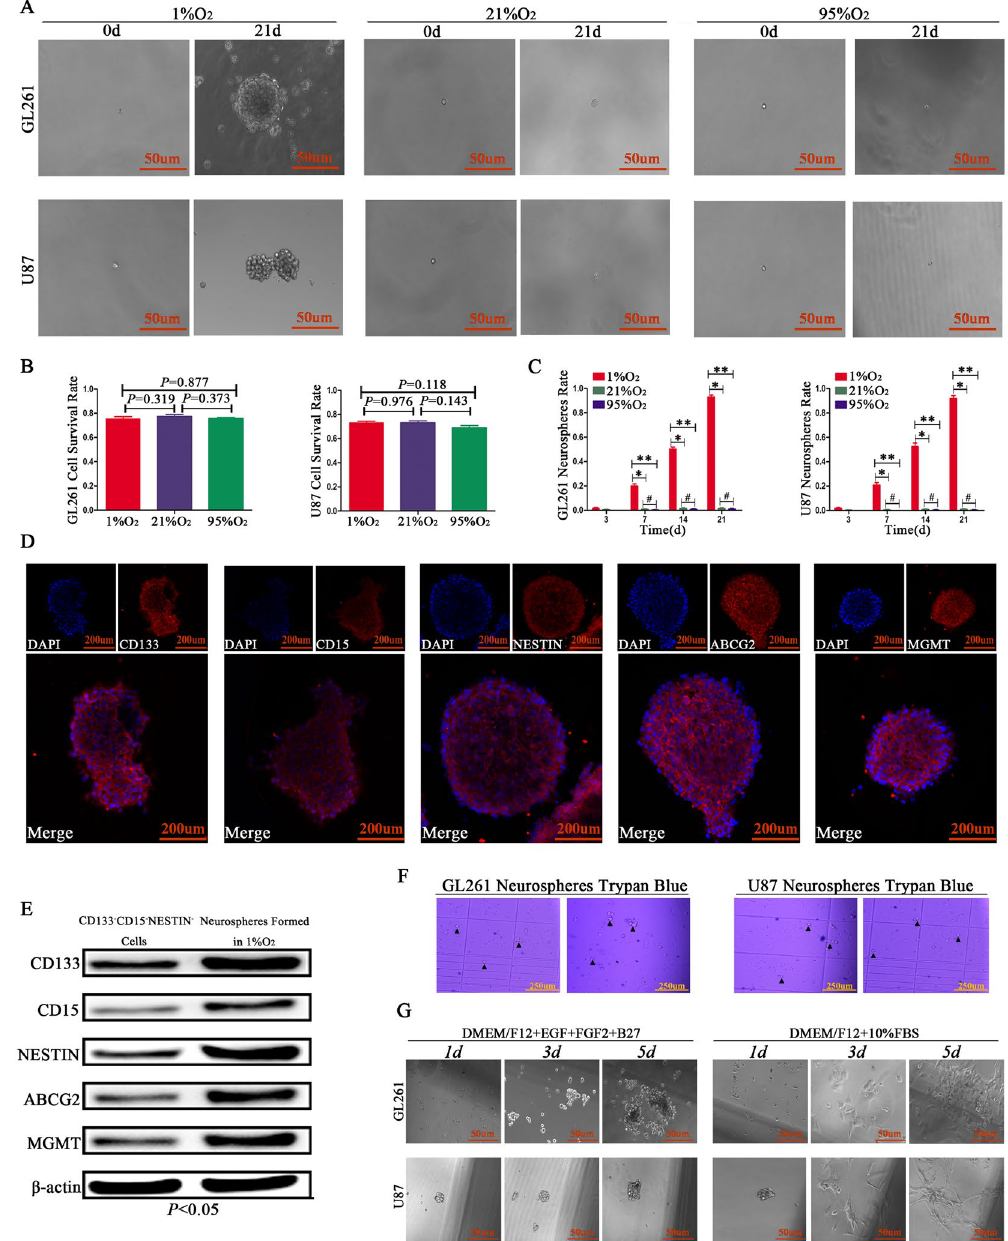
Figure 3. Neurospheres formed in 1%O 2 presented with features of GSCs. ( A–C ) Single GL261 and U87 CD133 − CD15 − NESTIN − cell was seeded in the wells of 96-well plates and cultured in 1%O 2 , 21%O 2 and 95%O 2 . Approximately 75% of cells survived after exposure to different oxygen levels for 3 days without a significant difference (d3 viable cells/d0 seeding cells). The neurospheres began to form after 1%O 2 exposure for 3 d, and approximately 20% of cells (d7 spheres/d3 surviving cells) from GL261 and U87 formed neurospheres on day 7. The neurosphere formation rates then significantly increased, and 50.2% ± 4.167 from GL261 and 53.0% ± 3.391 from U87 (d14 spheres/d3 surviving cells) formed neurospheres after hypoxia exposure for 14 d. More surprisingly, the sphere rates eventually reached 93.1% ± 5.541 from GL261 and 95.6% ± 2.665 from U87 (d21 spheres/d3 surviving cells) under hypoxic conditions for 21 days. However, in normoxia or hyperoxia, no distinct neurospheres formed, and most cells remained a single cell and eventually died ( * P < 0.05; ** P < 0.05; # P > 0.05, One-way ANOVA). ( D,E ) Newly formed GL261 neurospheres highly expressed the stem cell markers CD133, CD15 and NESTIN and the chemoresistance-related proteins ABCG2 and MGMT ( * P < 0.05, Paired-samples T Test). ( F ) Trypan blue indicated there were no cells with blue-staining in the cytoplasm. ( G ) Asymmetric division was detected for newly formed neurospheres, and the results indicated cells in neurospheres maintained growth in suspension with a sphere morphology when cultivated in GSC medium for 5 d; however, adherent growth with a differentiation style was induced after 10%FBS